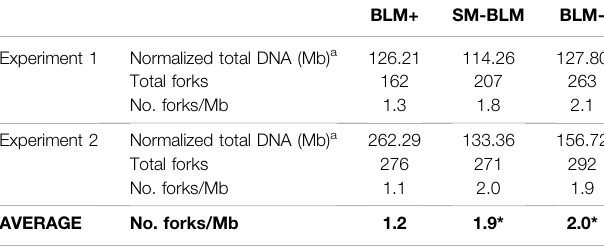
TABLE 1 | DNA replication fork density (forks/Mb DNA).